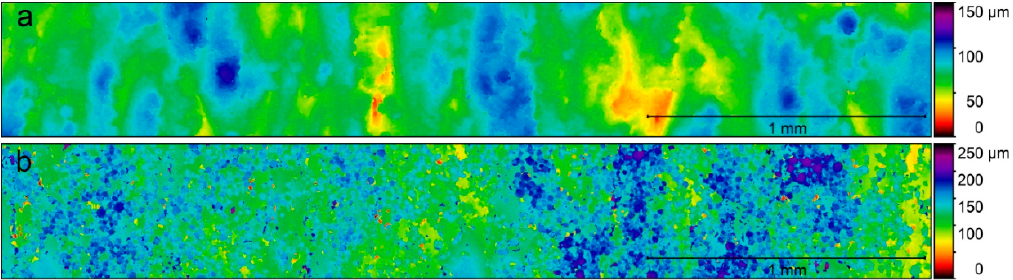
Figure 4. Surface topography in a false-color gradient of the large-diameter specimens fabricated with ( a ) new powder and ( b ) recycled powder.